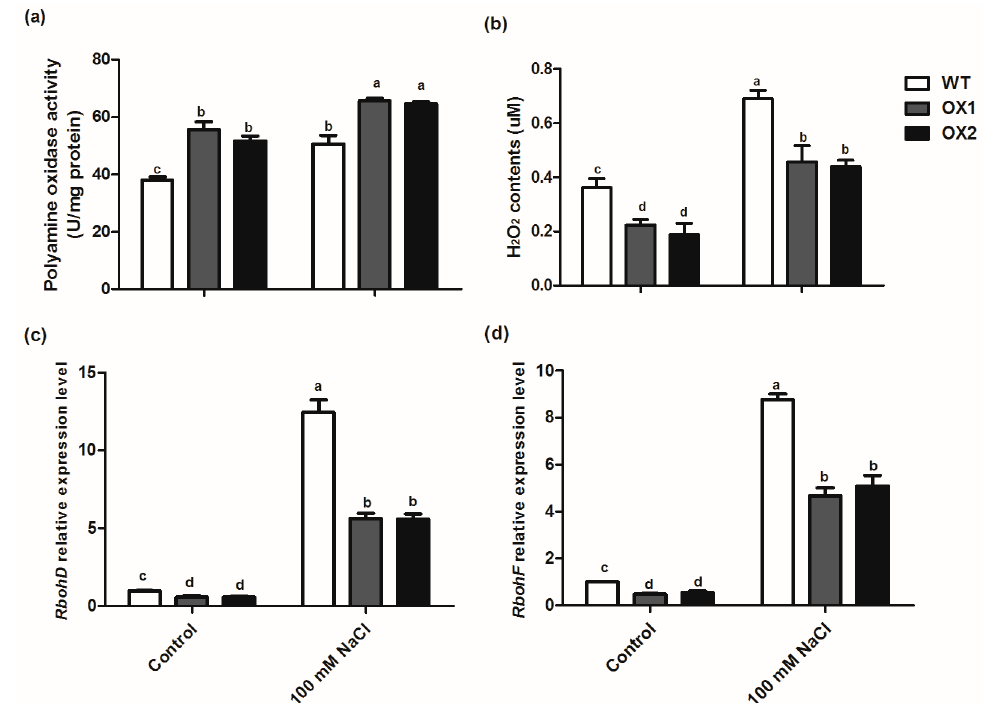
Figure 6. E ff ects of salt stress on polyamine oxidase (PAO) activity, H 2 O 2 content and mRNA levels of RbohD and RbohF in the leaves of wild type (WT) and BvM14-SAMDC -overexpression in WT Arabidopsis (OX). ( a ) PAO activity; ( b ) H 2 O 2 content; ( c ) mRNA levels of RbohD ; and ( d ) mRNA levels of RbohF under control and salt stress (100 mM NaCl) conditions. One unit of PAO activity was defined as the amount of enzyme required for catalyzing 1 mmol of Spd or Spm oxidation within 1 min. Di ff erent letters indicate significantly di ff erent at P < 0.05. Three biological replicates were performed.